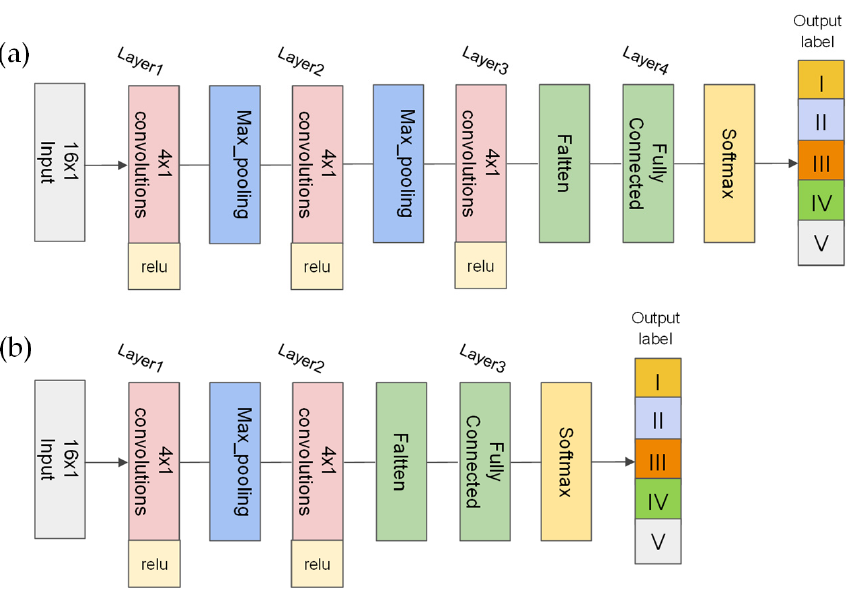
Figure 2. The architecture of the one-dimensional Convolutional Neural Network (CNN) for ( a ) soil salinization and ( b ) soil alkalinization modeling.